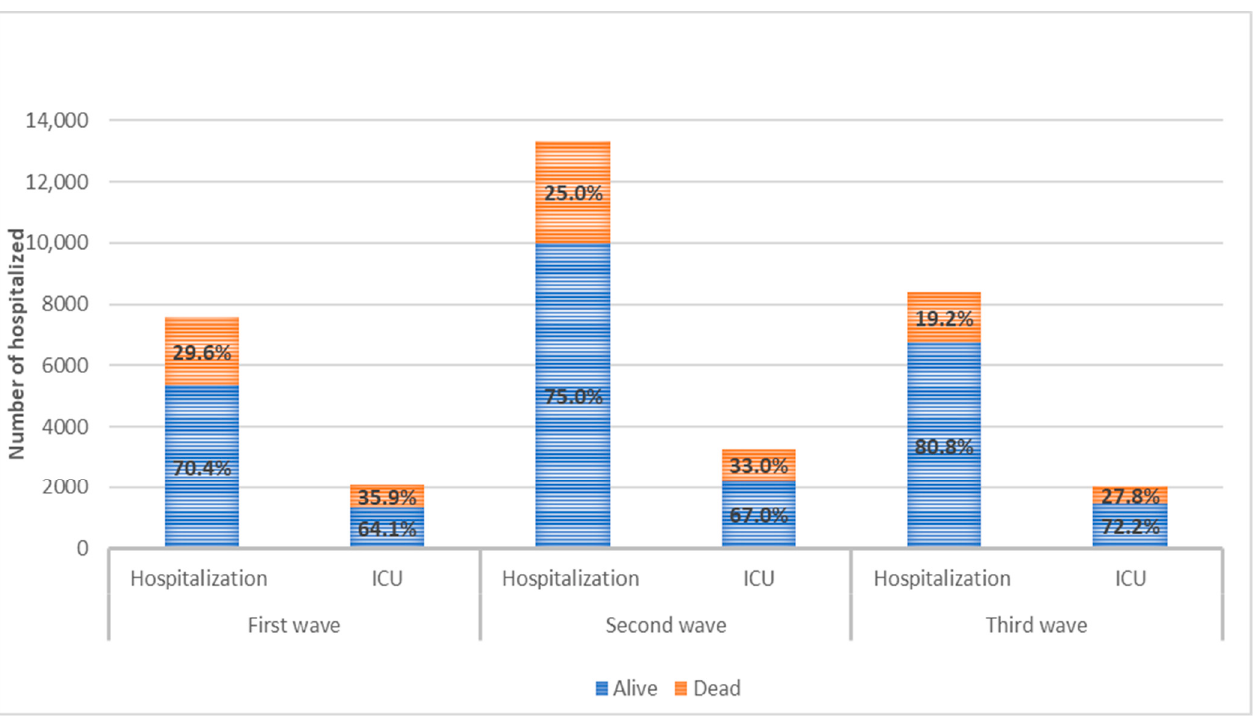
Figure 3. Mortality within 30 days from the first positive swab in hospitalized patients and in the subgroup of patients admitted to intensive care unit (ICU) in the three waves.